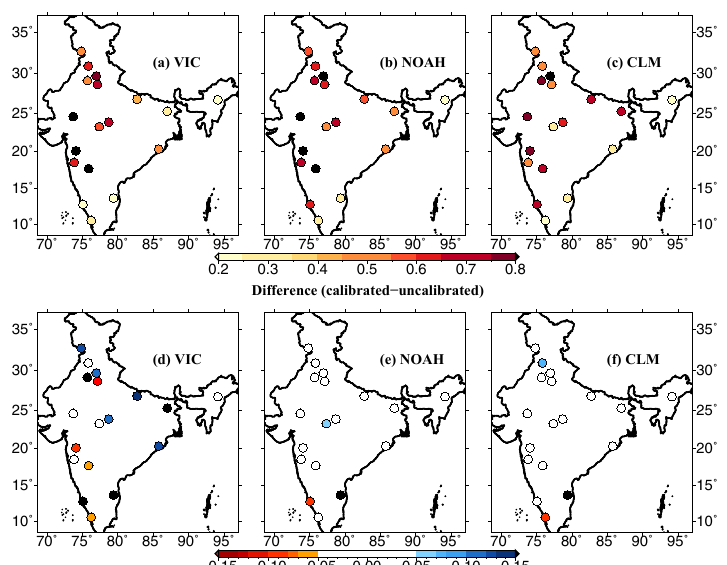
Figure 1. Correlation of weekly 60cm simulated soil moisture with IMD gauge-based soil moisture ( ∼ 60cm) during the monsoon season, 2009–2013. (a–c) Correlation for control (default or uncalibrated) setup for the VIC, NOAH, and CLM, respectively. (d–f) show differences (calibrated–uncalibrated) in the correlation